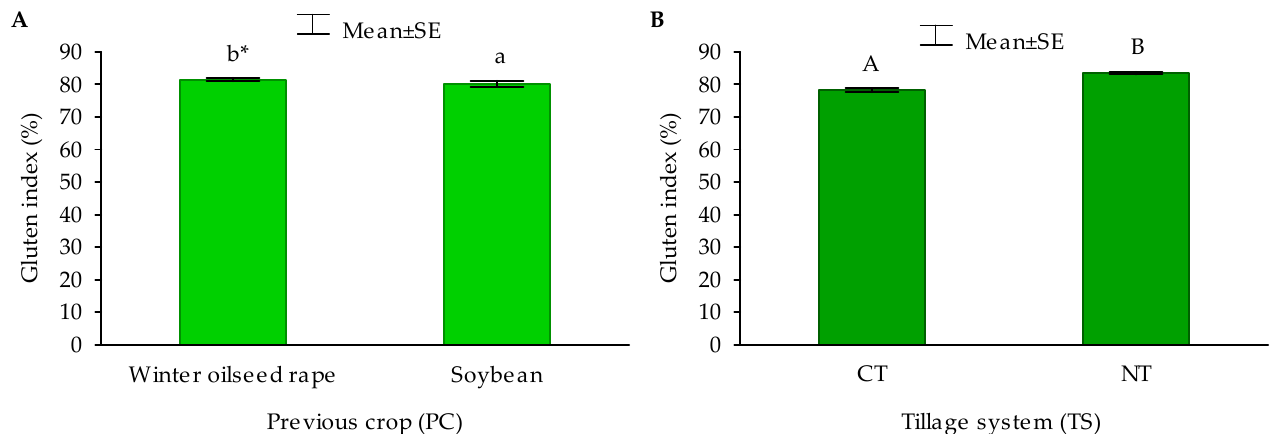
Figure 7. Gluten index for winter wheat grain depending on previous crop ( A ) and tillage system ( B ) (mean for 2014–2017). CT—Conventional tillage; NT—No-tillage. * Different letters denote significant differences ( p ≤ 0.05). The lowercase letters refer to previous crops (PC); the capital letters refer to tillage systems (TS).